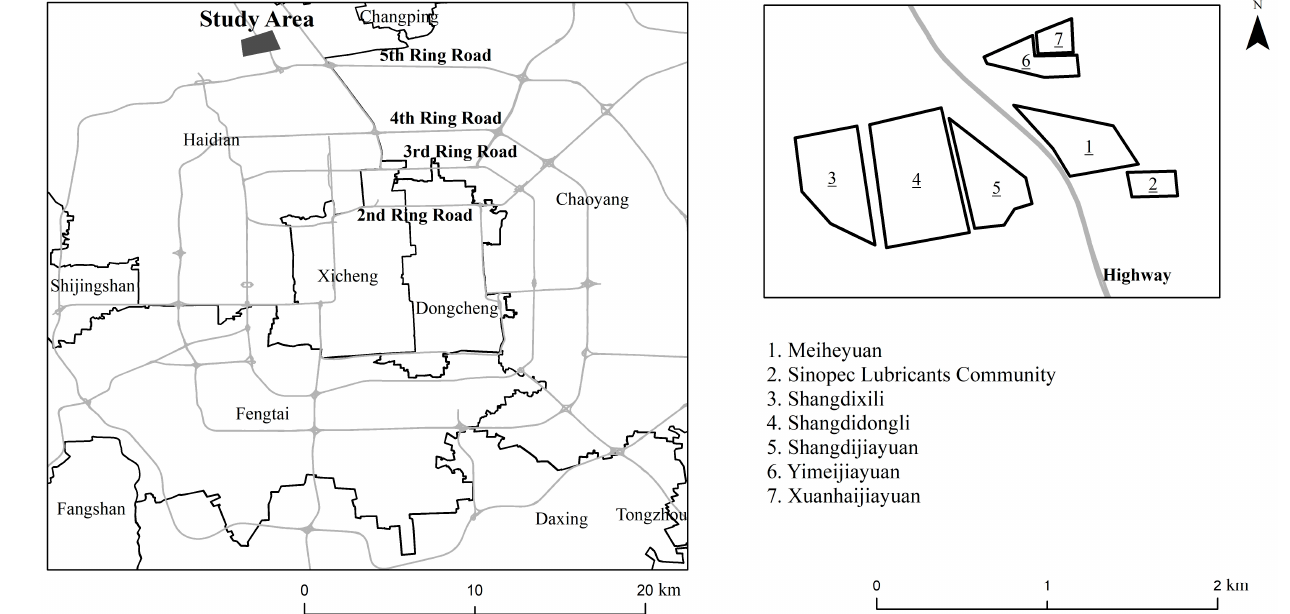
Figure 1. Study area.